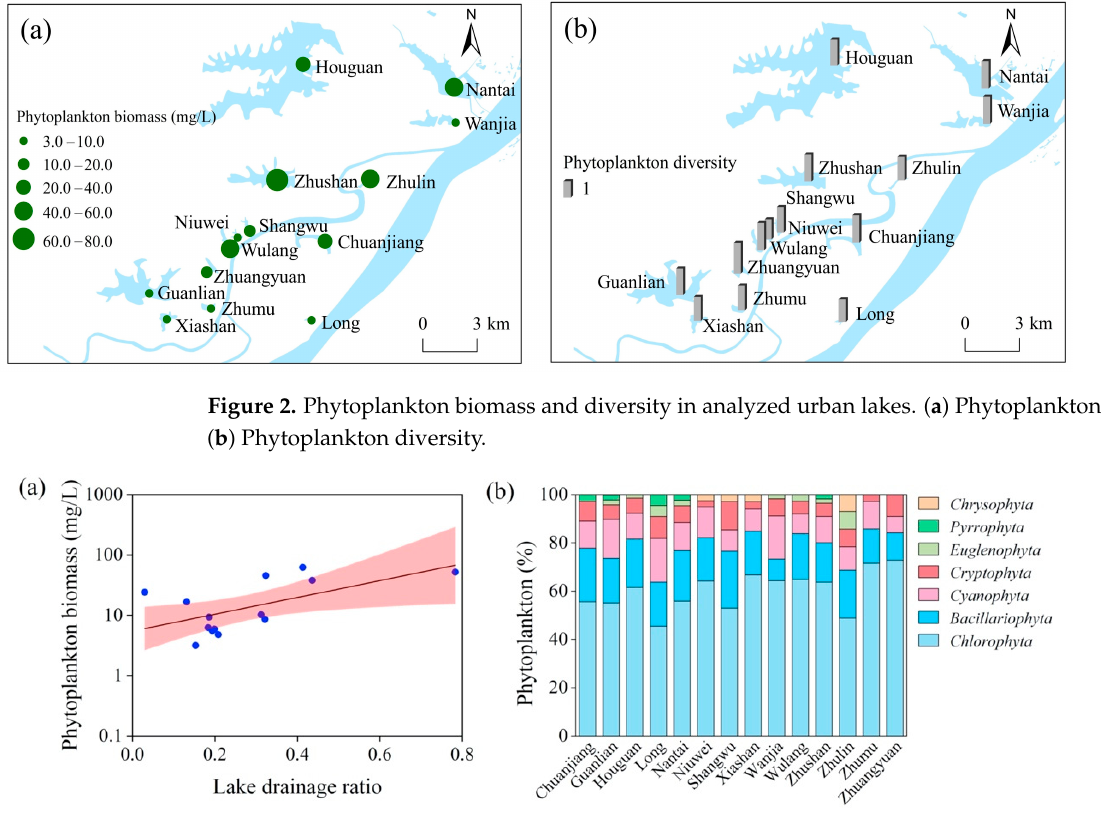
Figure 3. Correlations between phytoplankton biomass and lake drainage ratio values and phyto- plankton community in the analyzed urban lakes. ( a ) Correlation between phytoplankton biomass and lake drainage ratio values; ( b ) Phytoplankton community. The 95% confidence intervals are denoted by light red shading. The lake drainage ratio was calculated by dividing the catchment area by the lake area.